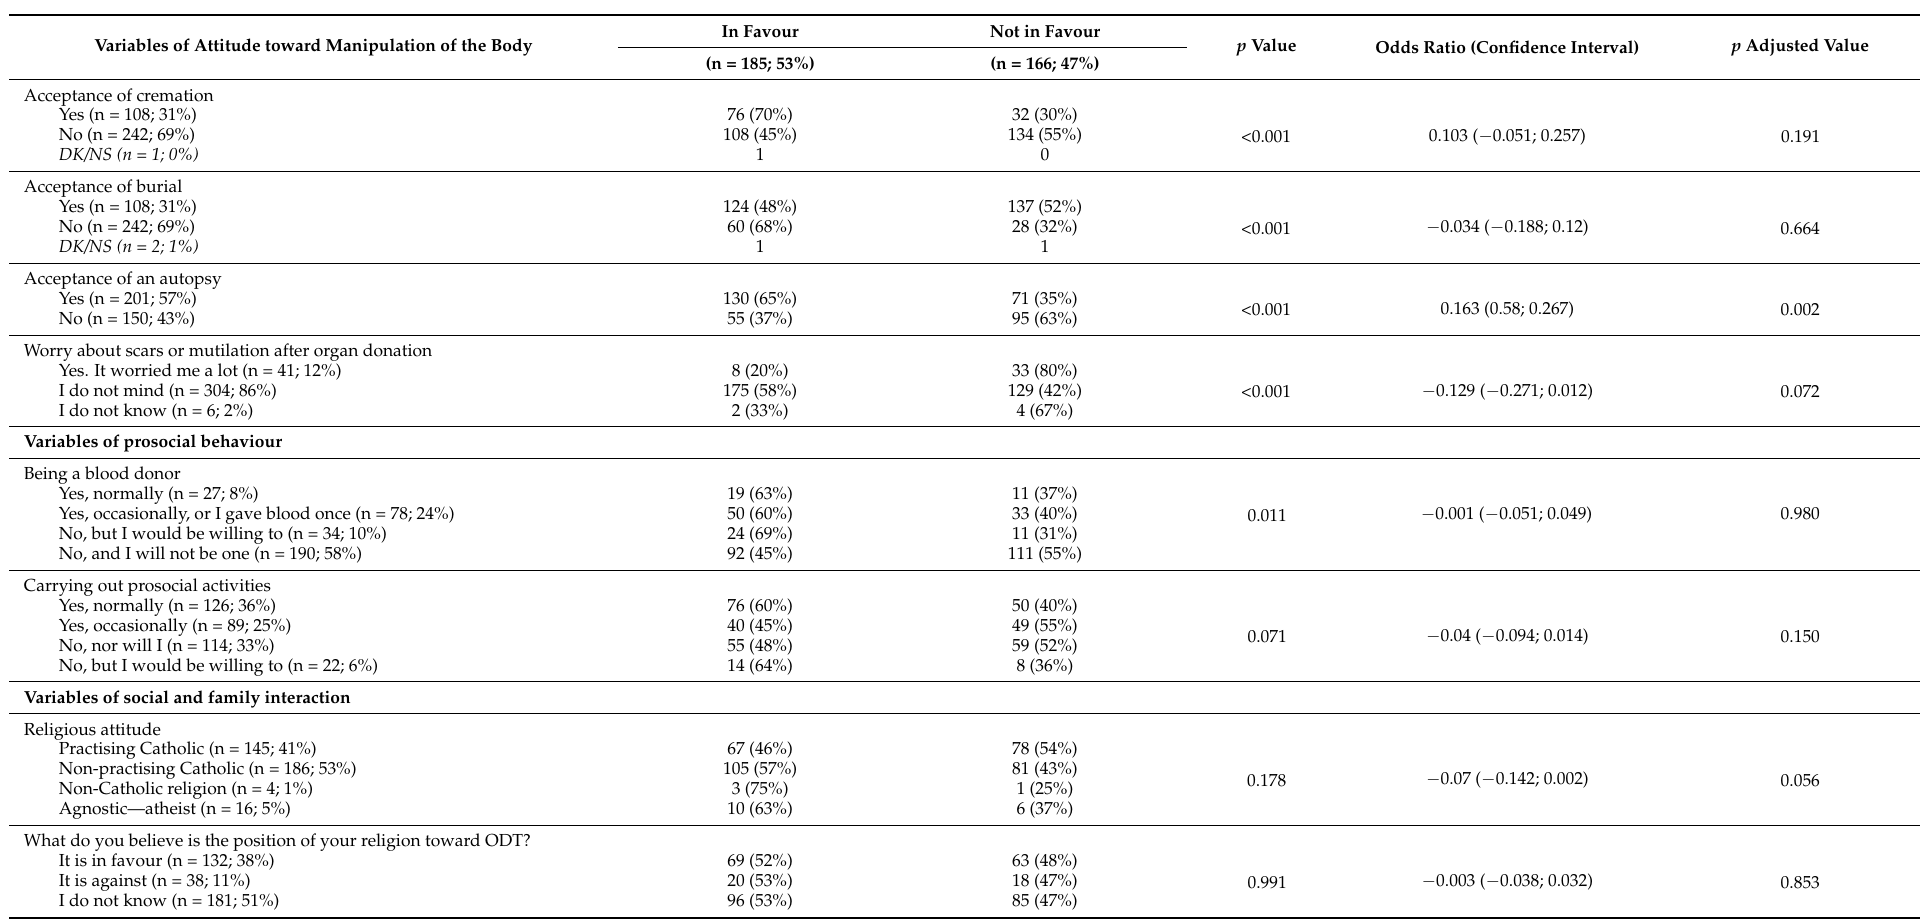
Table 4. Analysis of the influence of variables of attitude toward the manipulation of the body, of prosocial behaviour and religion, on attitude toward organ donation upon